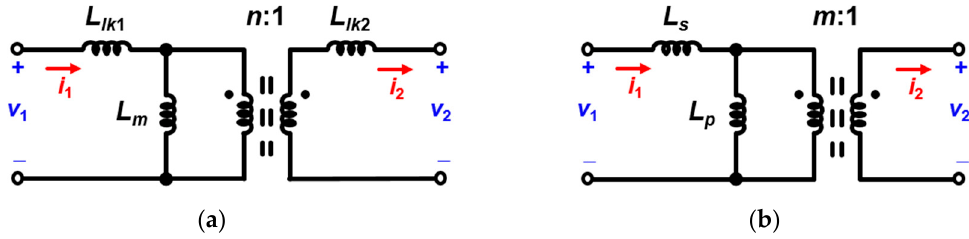
Figure 4. Different equivalent circuit models of the transformer ( a ) T model and ( b ) L model. Figure 4. Di ff erent equivalent circuit models of the transformer ( a ) T model and ( b ) L